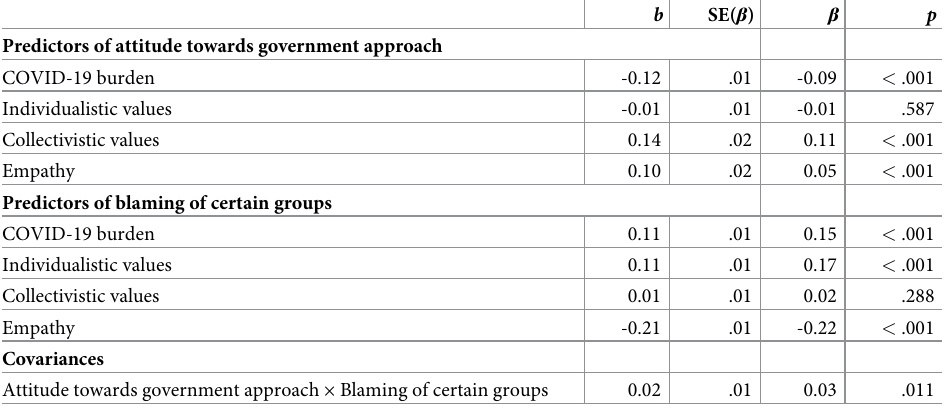
Table 2. Direct effects regression model with attitude towards government approach and blaming of certain groups regressed on COVID-19 burden, individualistic values, collectivistic values, and